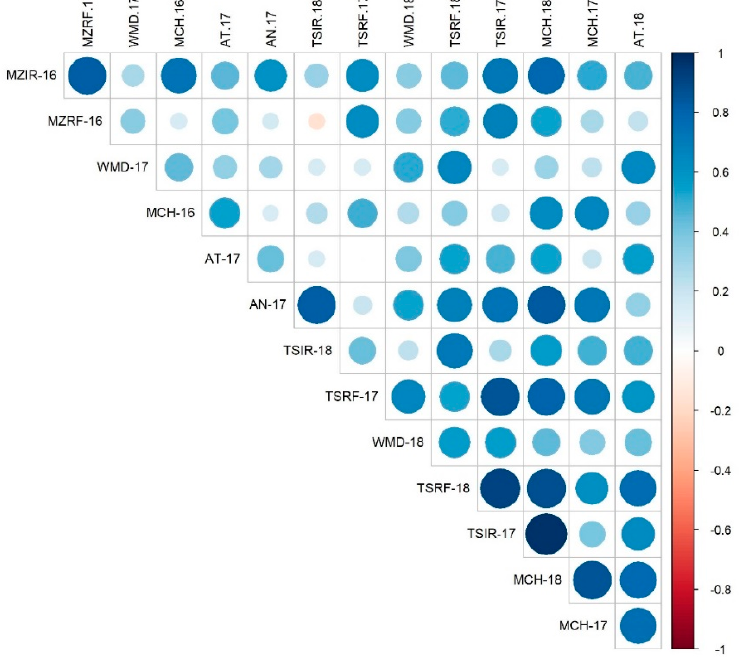
Figure 2. Estimated pairwise genetic correlation between 14 environments of grain yield of durum wheat tested genotypes.